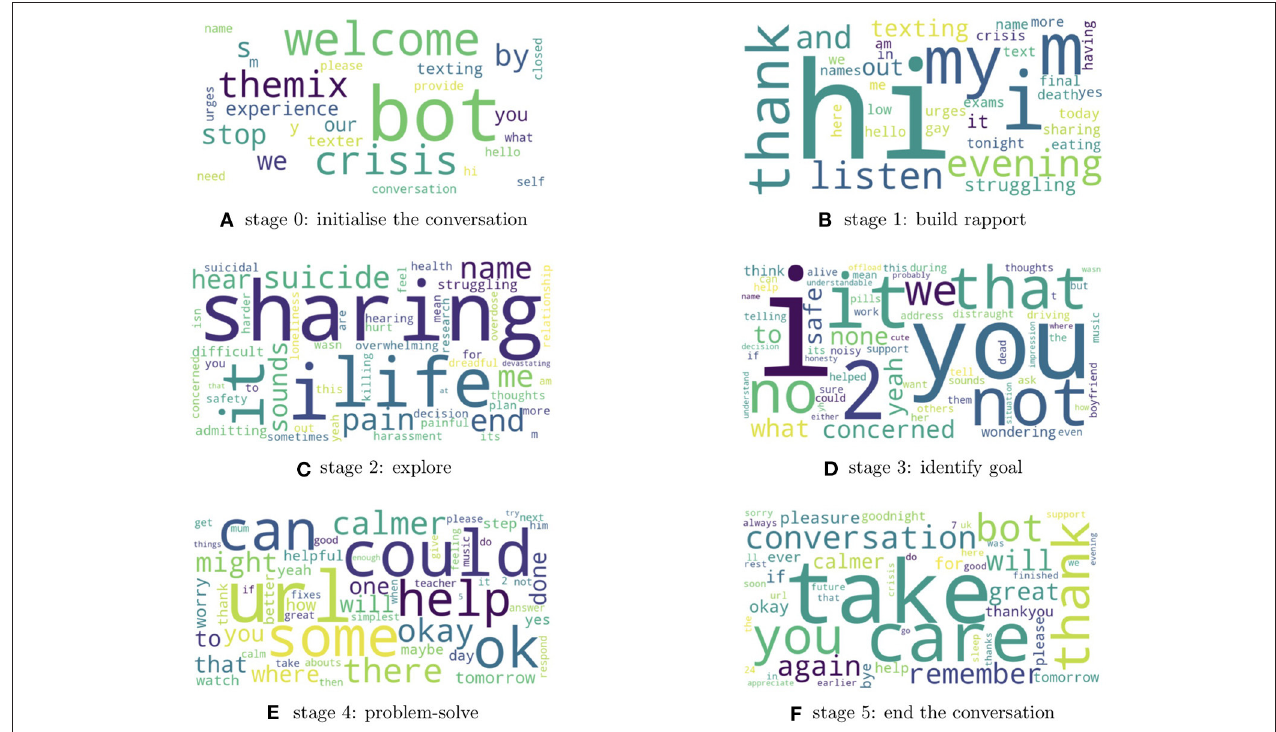
FIGURE 4 | Word clouds for LIME-derived words that best explain the model prediction for each conversation stage. (A) Bot messages are detected from the initialisation . (B) Greeting words are frequent when building rapport . (C) Volunteer begins to explore the texter’s problem with key words from the discussion featuring “sharing” and “life.” (D) Volunteer works to identify goals with the texter and these messages usually start with first-person and second-person pronouns. (E) Texter-specific solutions are suggested such as a “helpful” “URL.” (F) The conversations are brought to a close using phrases like “take care” and “bye”.